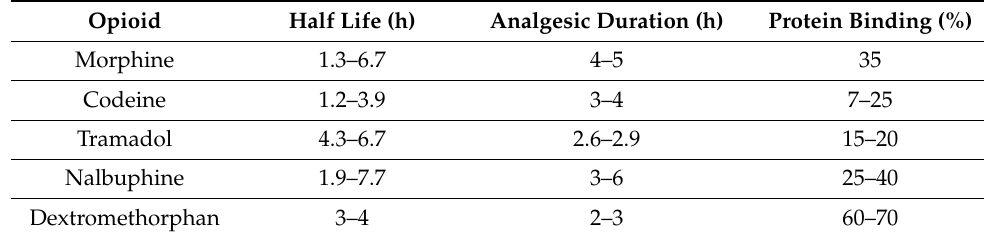
Table 1. Target opioids with their half-life, analgesic duration and protein binding. Opioid Half Life (h) Analgesic Duration (h) Protein Binding (%)